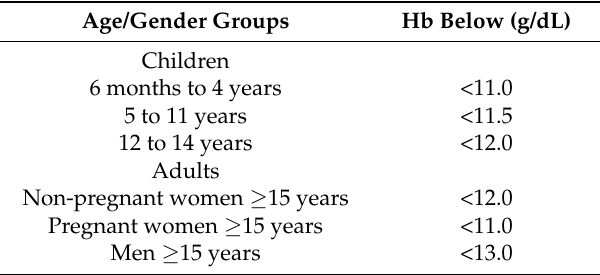
Table 1. Cutoff of hemoglobin (Hb) for diagnosis of